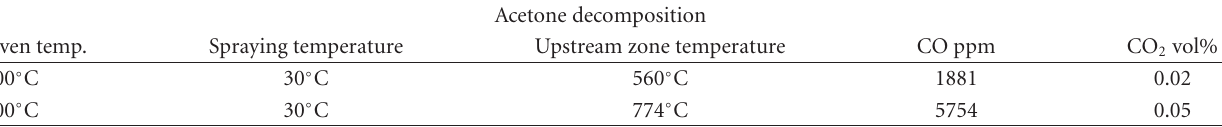
Figure 7: SEM images carbon nanotubes synthesized to 800 ◦ C of the four zones analyzed. Table 3: Experimental percentage weight of propanone